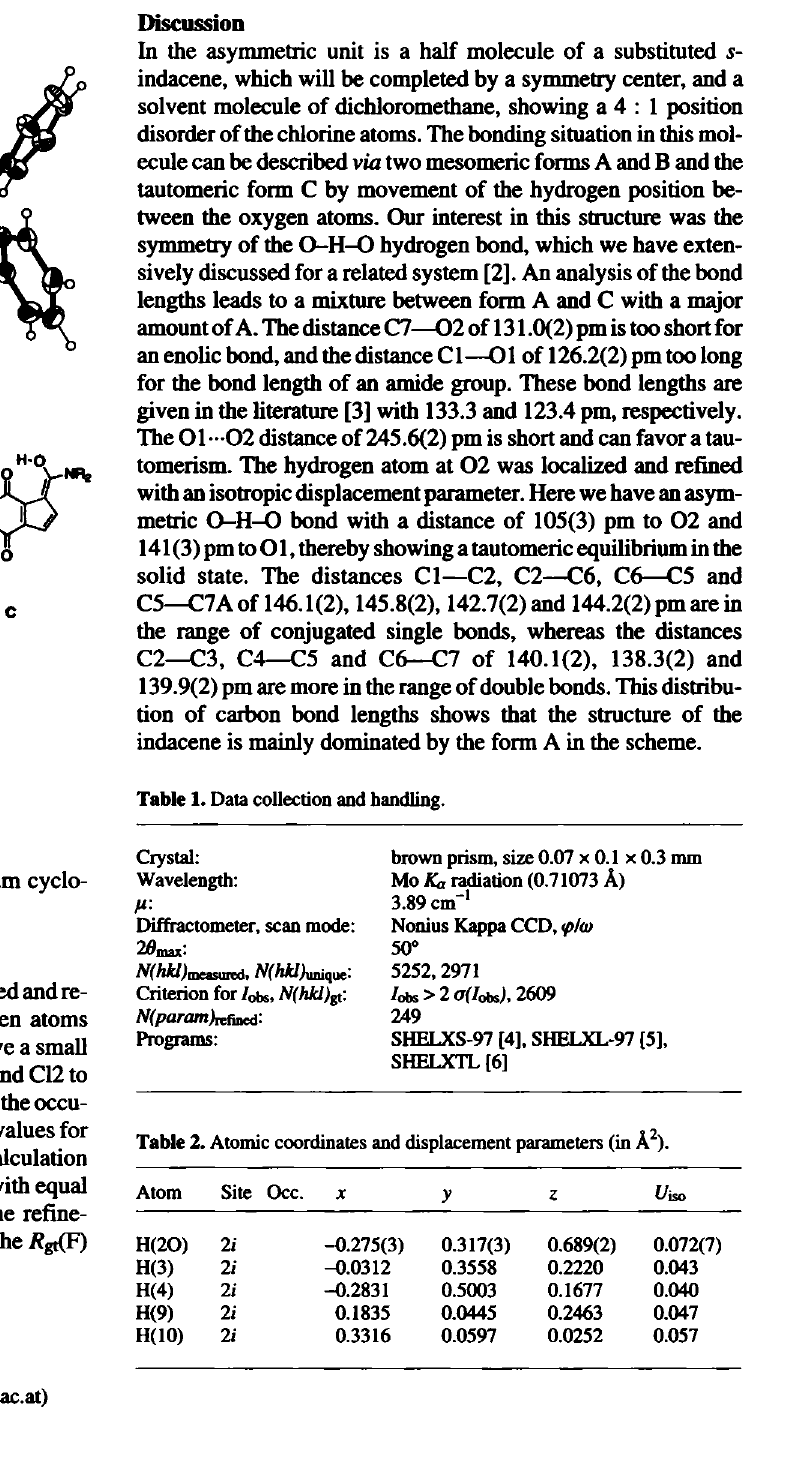
Table 2. Atomic coordinates and displacement parameters (in Â 2